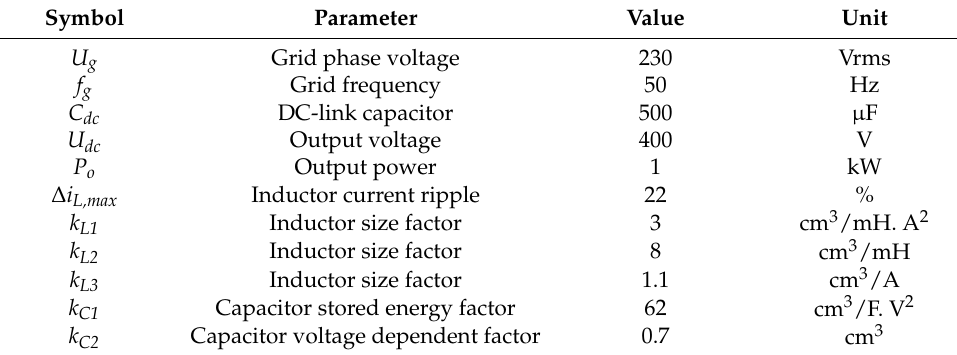
Table 1. Case Study Specification of Single-Phase Boost PFC.